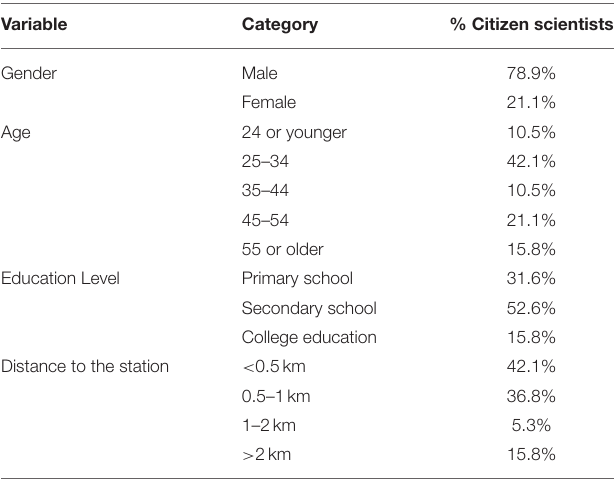
TABLE 2 | Diversity in gender, age, education level, and distance to the monitoring station of the 19 trained citizen